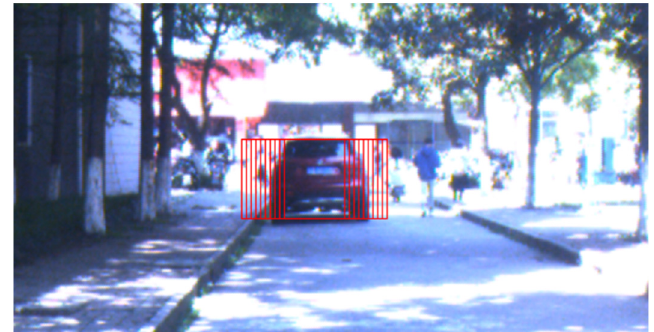
Figure 12. Sliding window detection.